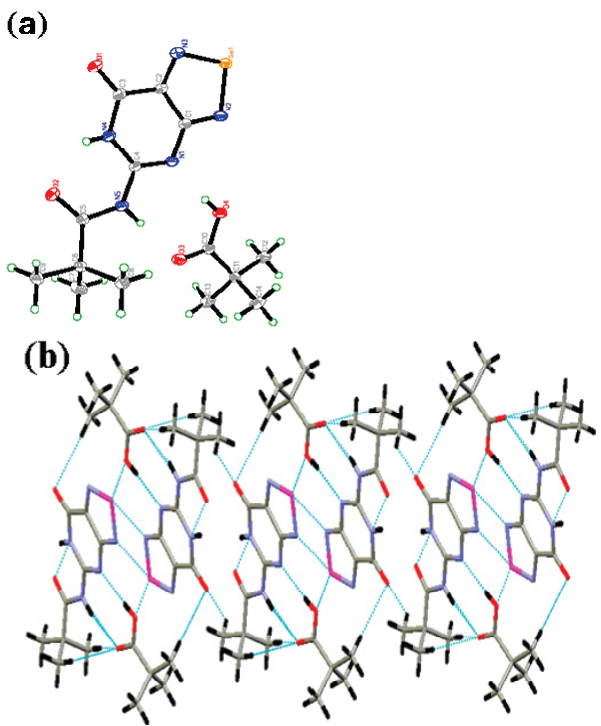
Figure 41. (a) ORTEP diagram (50% probability) of complex of 36 with pivalic acid; (b) two-dimensional polymeric crystal structure . (b) 3 viewed down crystallographic a axis. Hydrogen bonds are shown as dashed